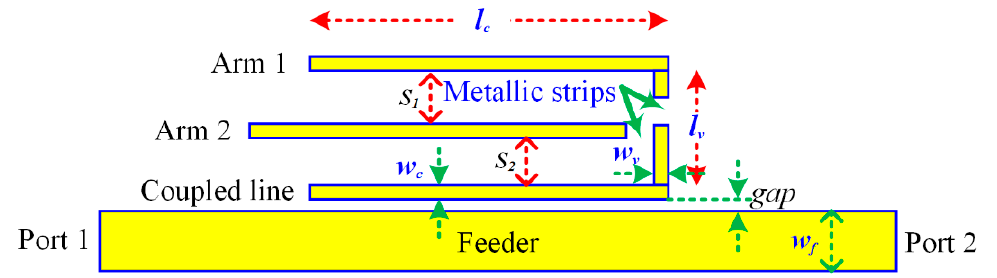
Figure 4. Geometry of the proposed resonator. Table 1. Physical parameters of single coupled-line resonator.